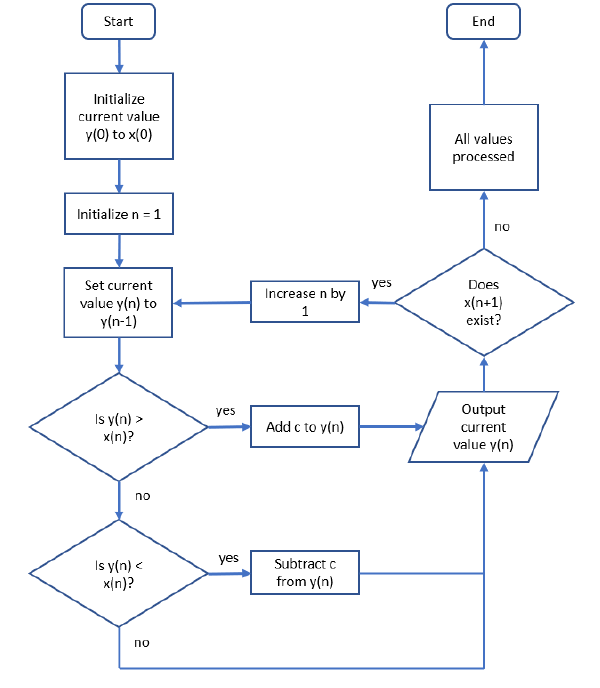
Figure 5. Linear baseline